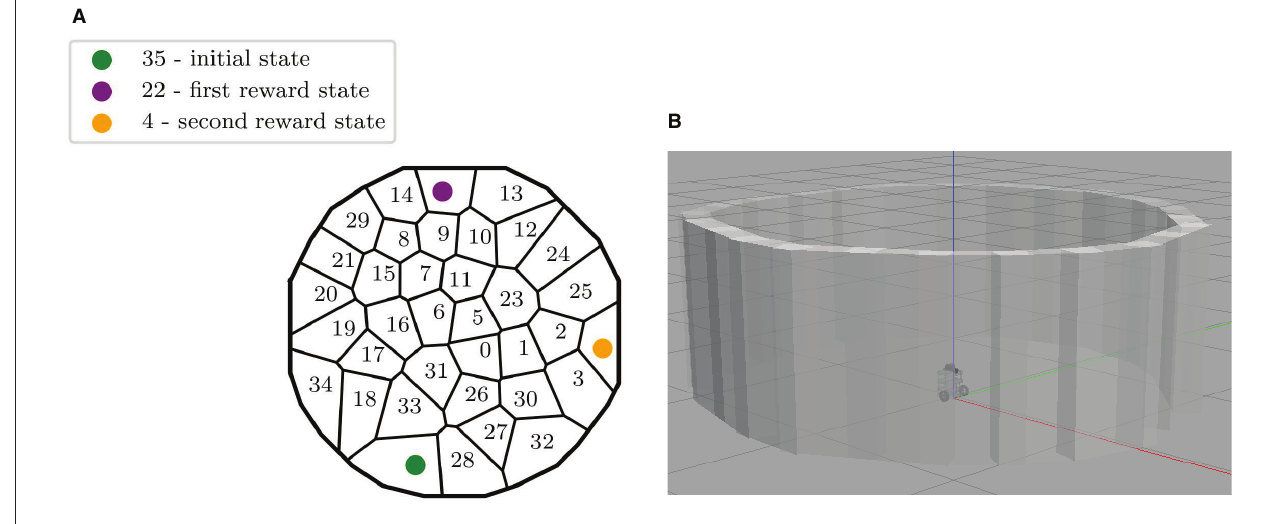
FIGURE 2 | Description of the experimental set-up. (A) Map of the discrete states of the maze, identified by the robot during the exploration of Gazebo. The initial state and the two rewarding states are also highlighted. (B) The ROS Gazebo simulated Turtlebot 3 in the center of the circular